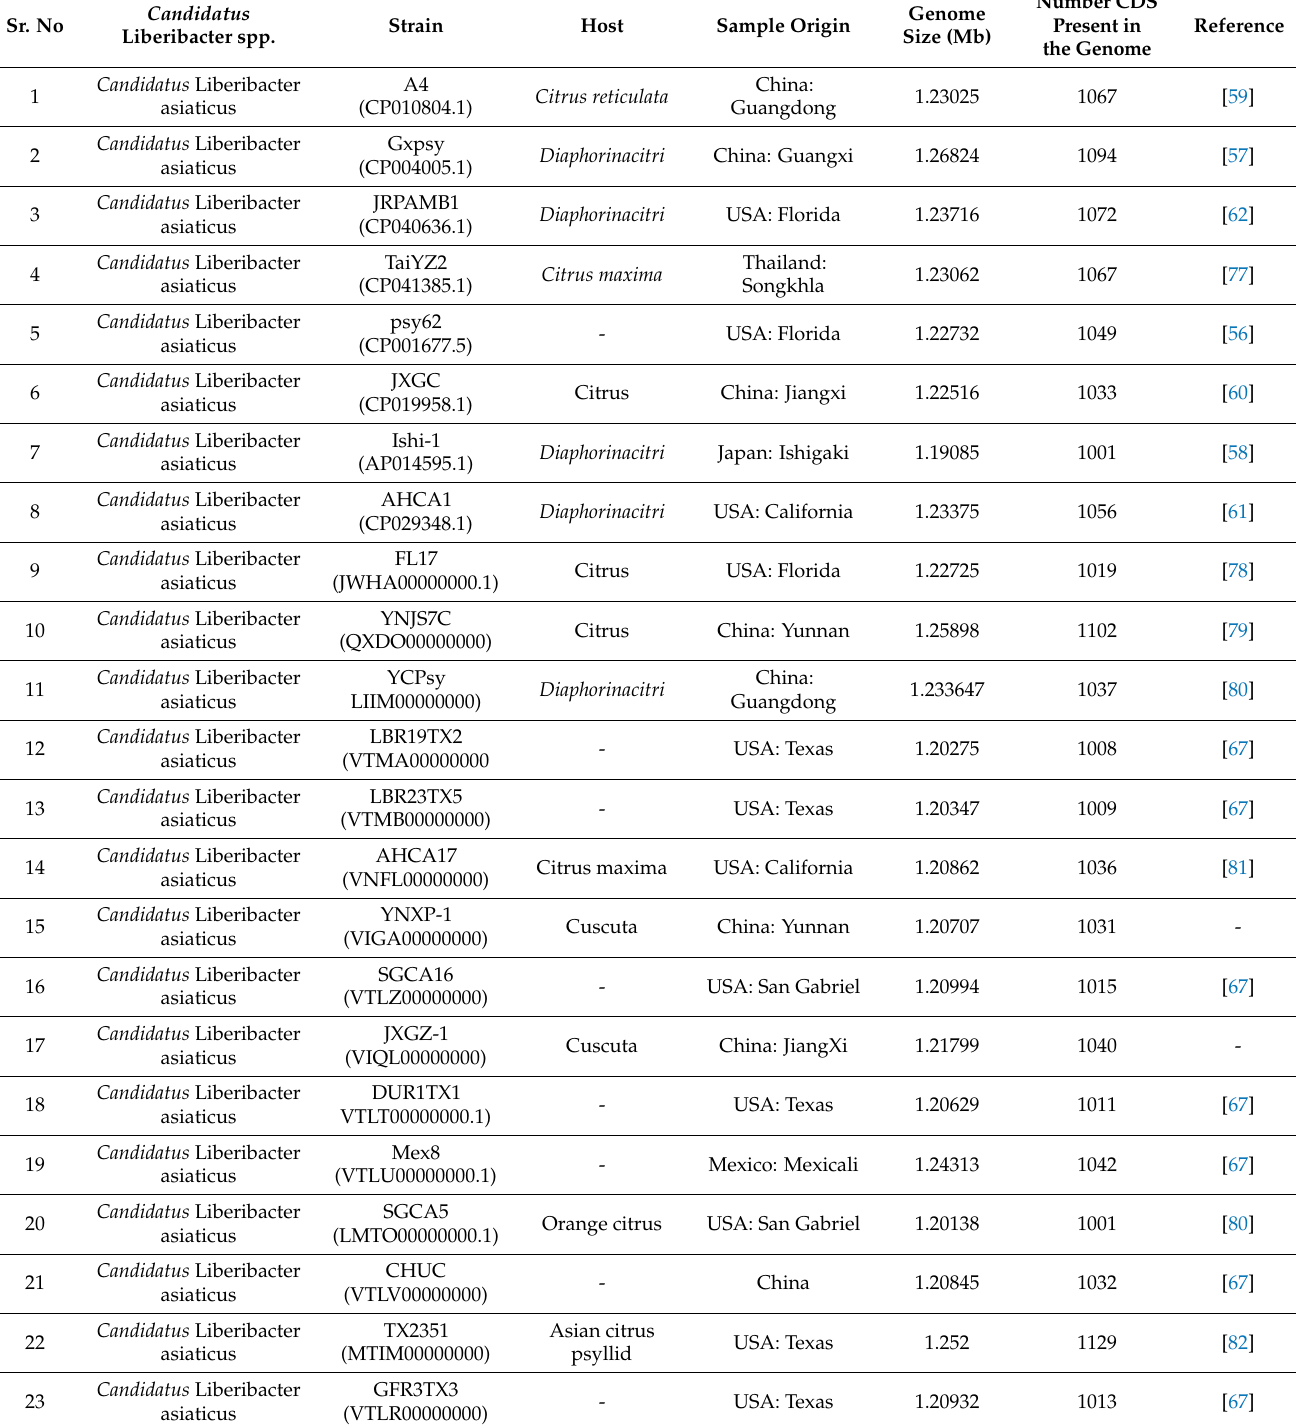
Table 2. Details of sequenced genomes of C Las, C Lam, and C